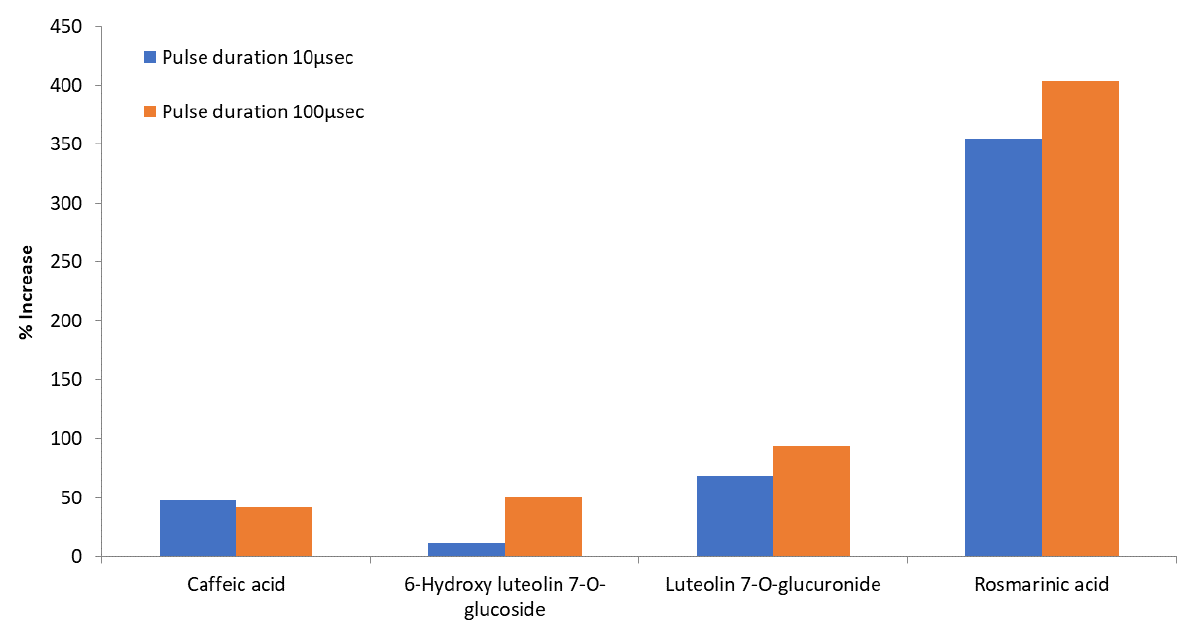
Figure 4. Comparison of the effect (% increase) of different pulse time durations on the extraction of individual phenolics in the same ethanol/water ratio (25% EtOH).